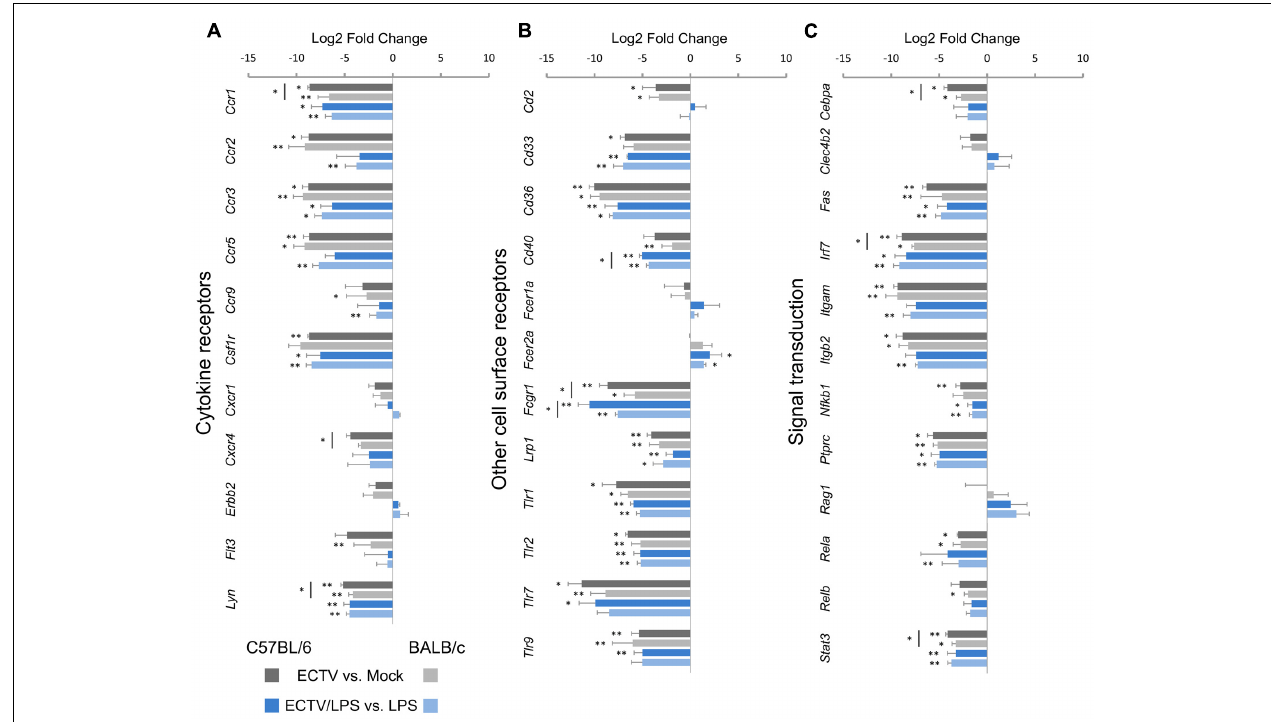
FIGURE 6 | ECTV similarly affects genes for (A) cytokine receptors and (B) other cell surface receptors, and (C) genes involved in signal transduction in GM-BM from C57BL/6 and BALB/c mice (unpaired Student’s t -test; ∗ P < 0.05, ∗∗ P < 0.01).